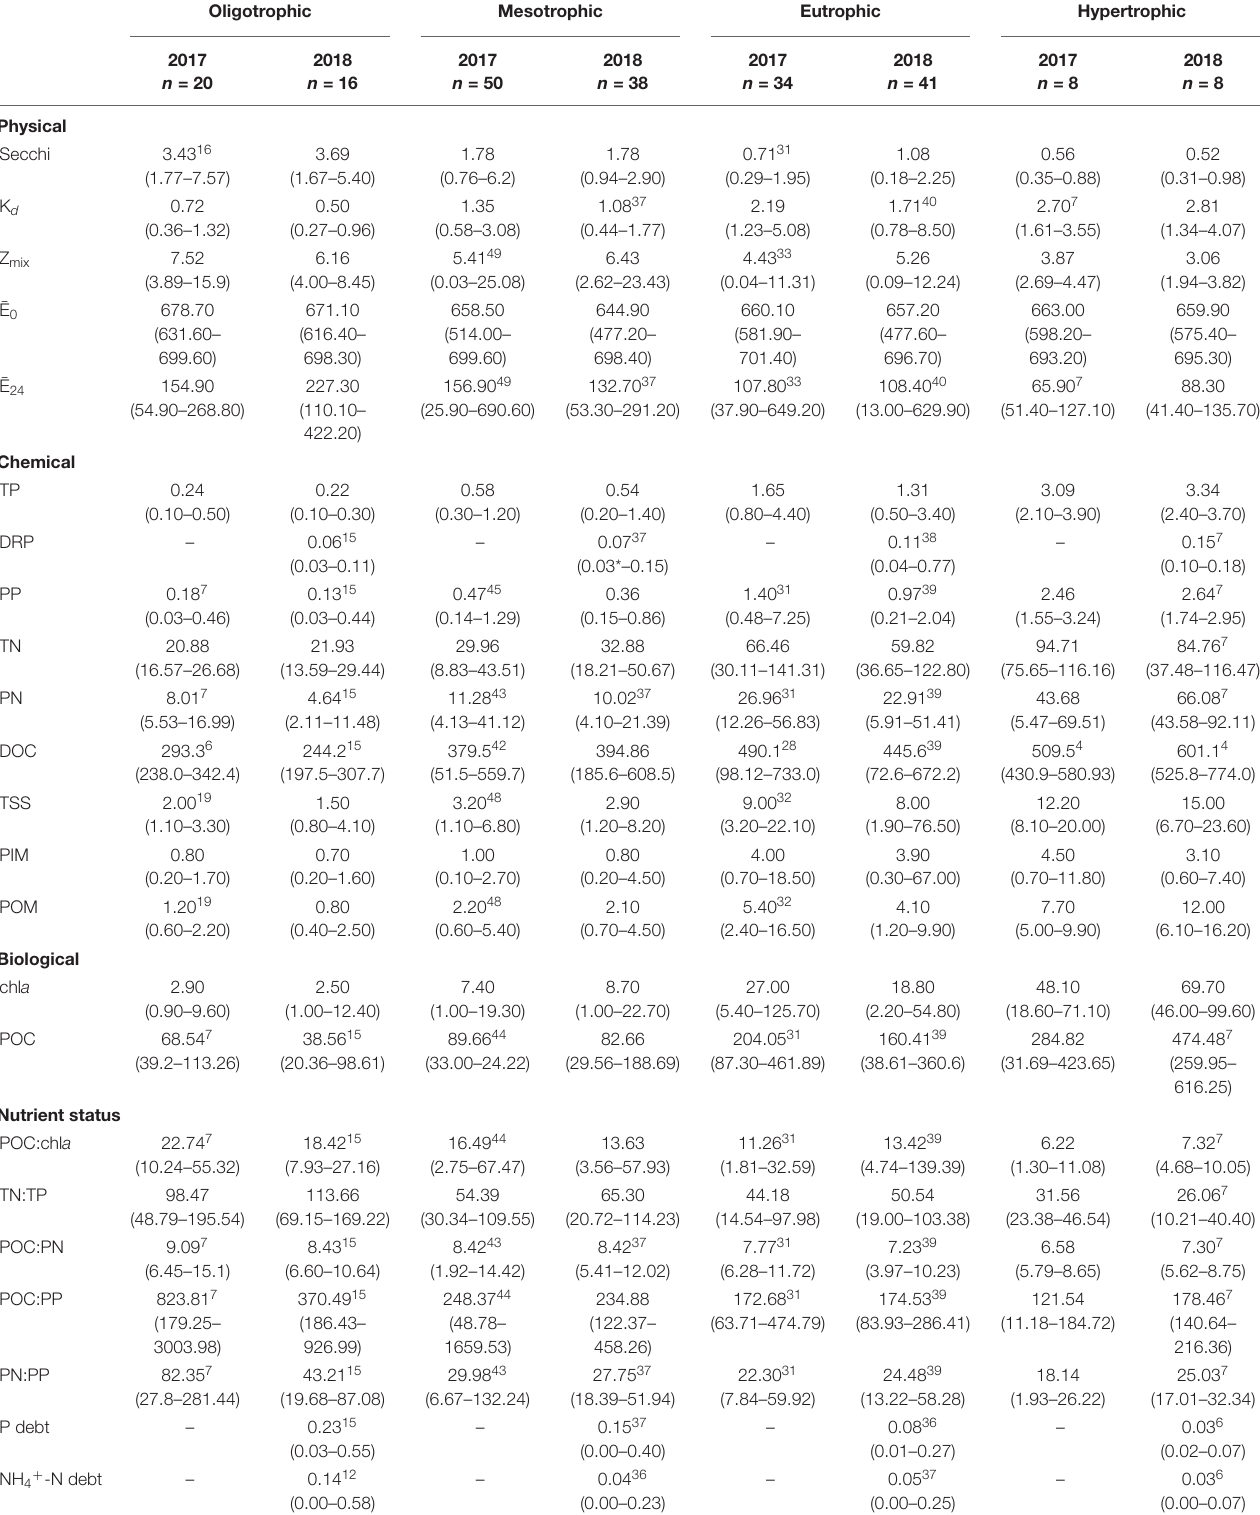
TABLE 4 | Limnological parameters for the 32 reservoirs sampled during the 2-year sample window. Shown are arithmetic means and ranges (minimum-maximum) of n samples grouped along the trophic gradient. Oligotrophic